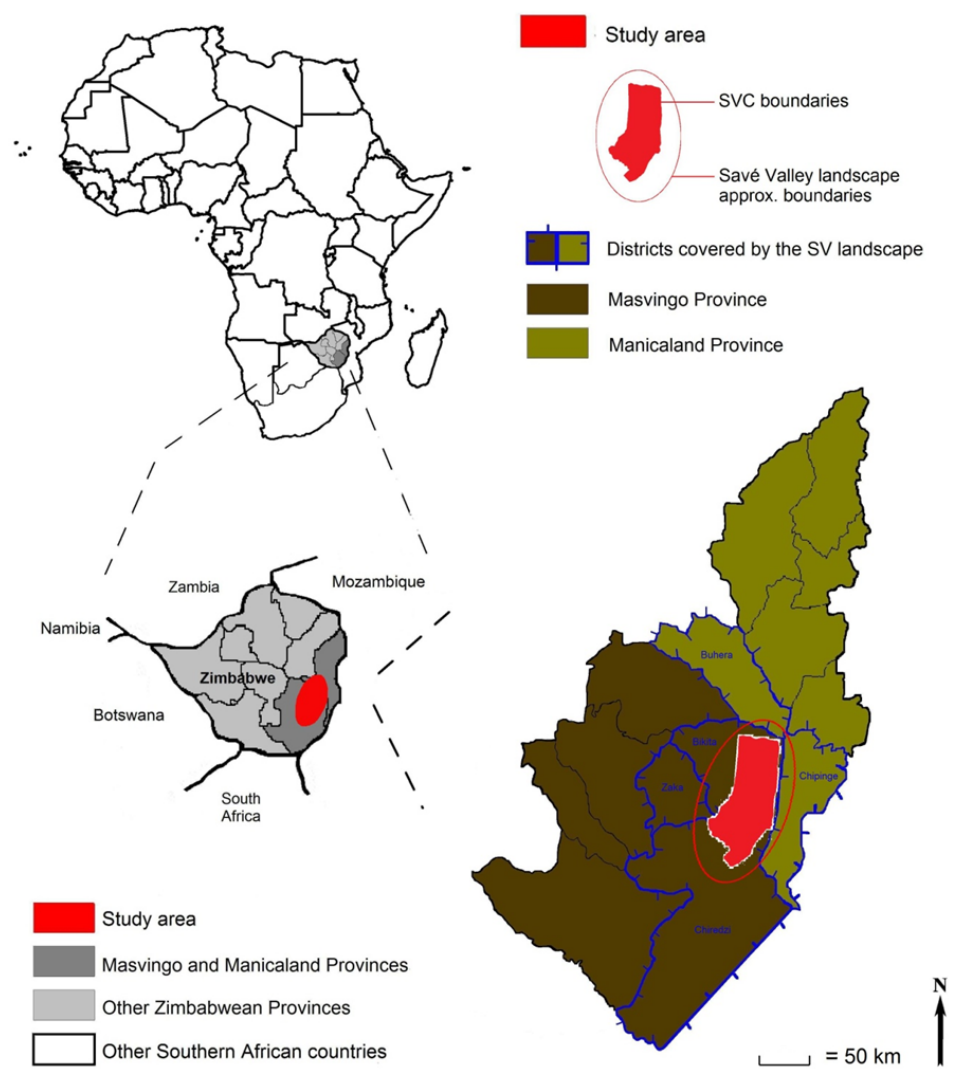
Figure 2. Location of the SVC site (Savé Valley Conservancy) within Zimbabwe’s administrative